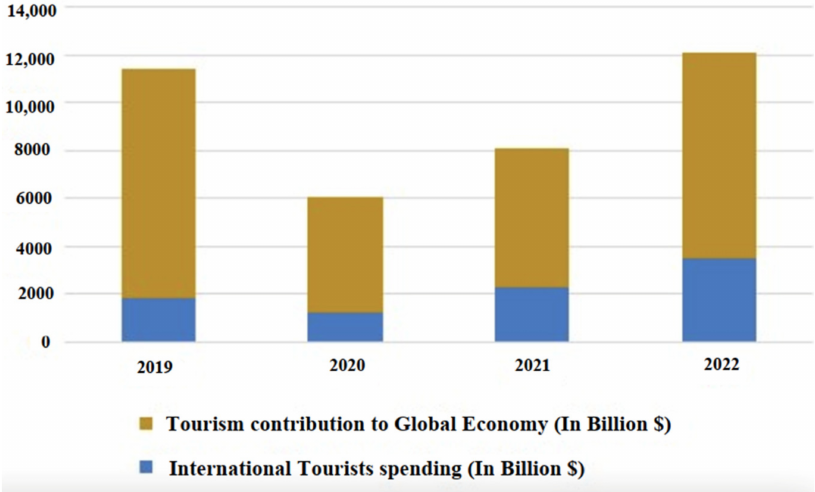
Figure 1. Monetary effect of tourism and economy. Source: Authors’ interpretation from recent